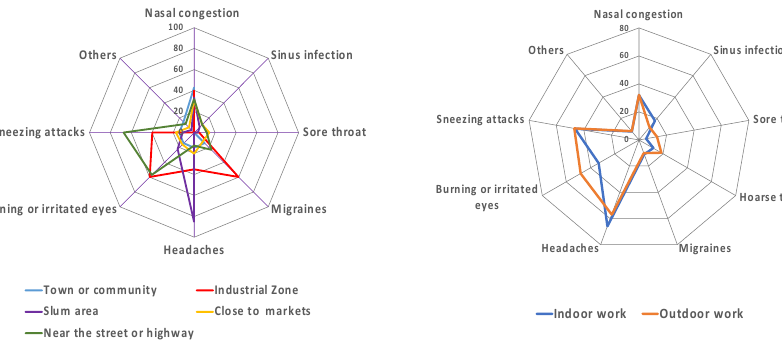
Figure 5. Health symptoms of socio-economic groups among different work environments.